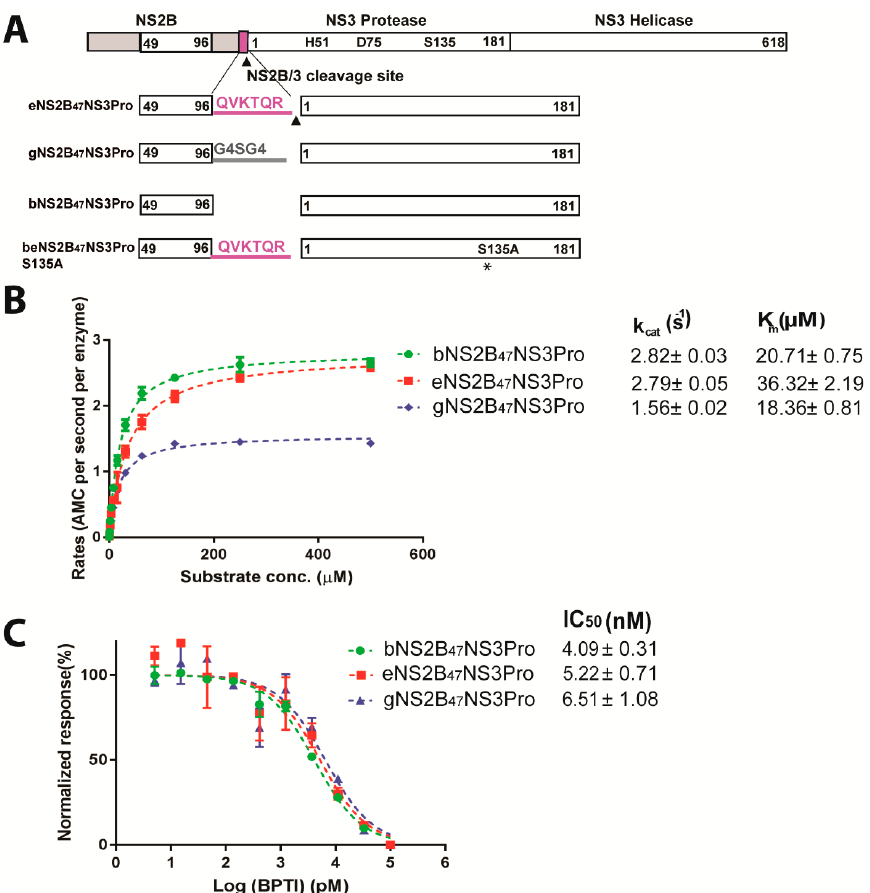
Figure 1. Schematic of construct design and characterization of protease activity from three different DENV4 NS2B 47 NS3 proteases. ( A ) Schematic of construct design of DENV4 NS2B 47 NS3Pro with three different linkers, e, g and b-. The beNS2B 47 NS3Pro S135A was created by inserting seven amino acids from NS2B/NS3 cleavage junction and by mutating the active serine residue 135 to alanine. The mutation, S135A, on beNS2B 47 NS3Pro is indicated in asterisk. ( B ) The protease activity of different NS2B 47 NS3Pro. The b- and e-NS2B 47 NS3Pro have similar k cat while gNS2B 47 NS3 Pro showed the lowest reaction rates. ( C ) The effect of different linkers on BPTI inhibition of the protease. The three constructs have similar inhibition efficiency indicating that the effect on linker on the substrate-binding is minimal in DENV. The standard deviations are represented by error